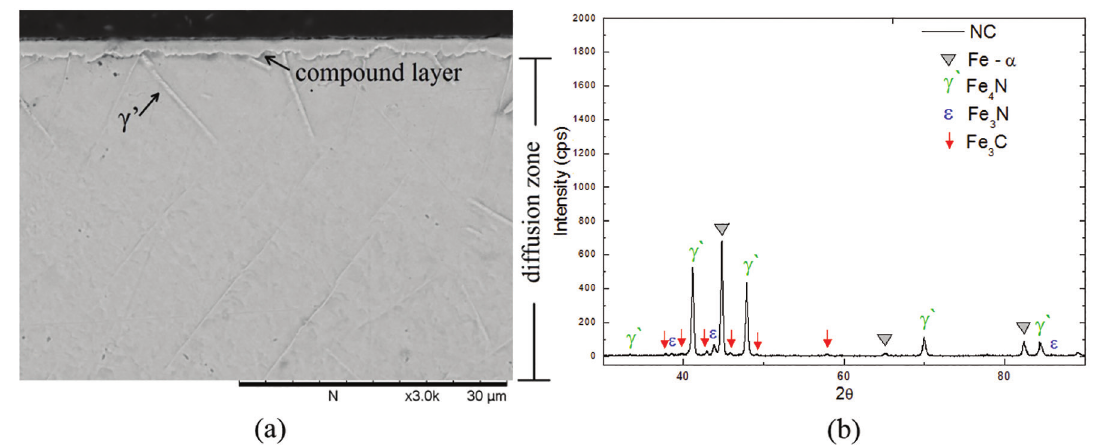
Figure 5: Sample NC: (a) scanning electron microscopy and (b)